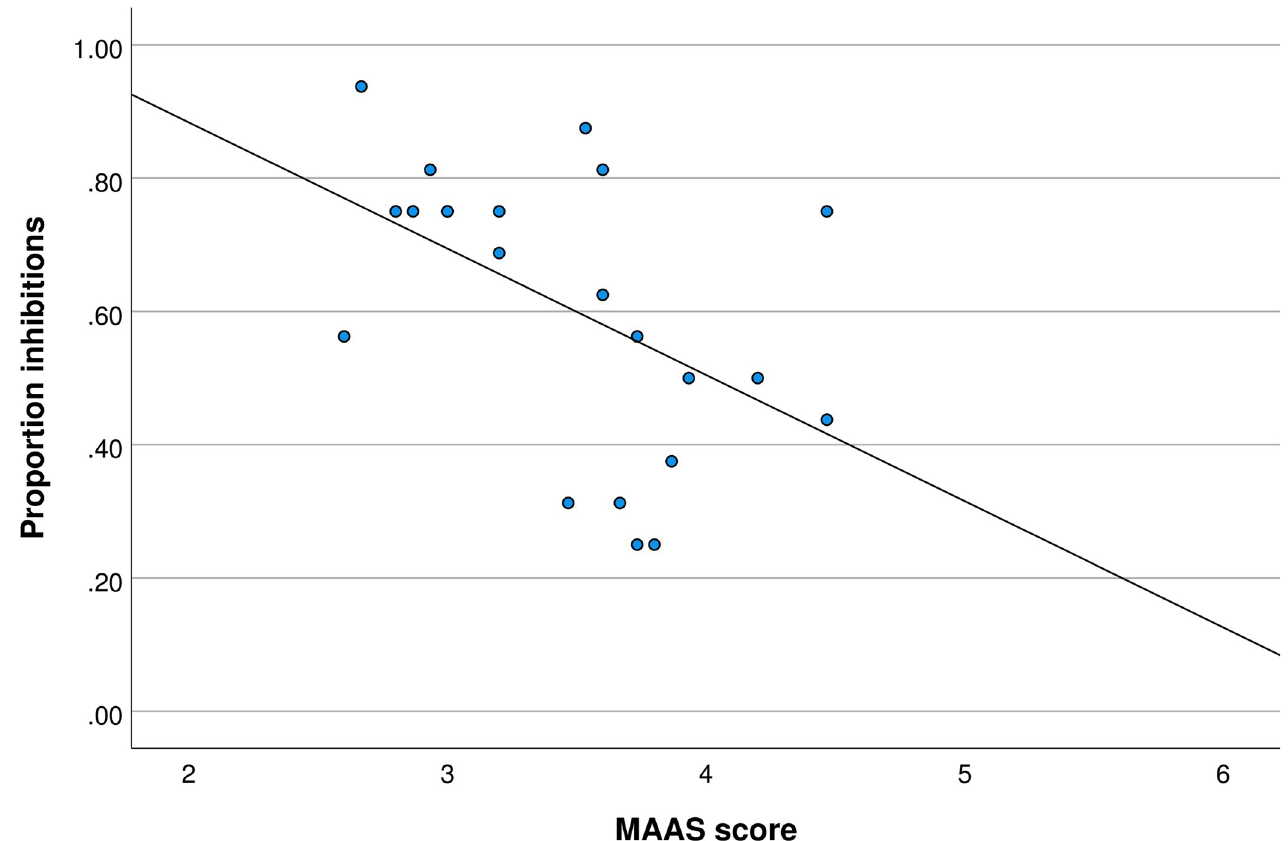
Fig 3. MAAS score and proportion inhibitions for faces viewed as higher than moderately